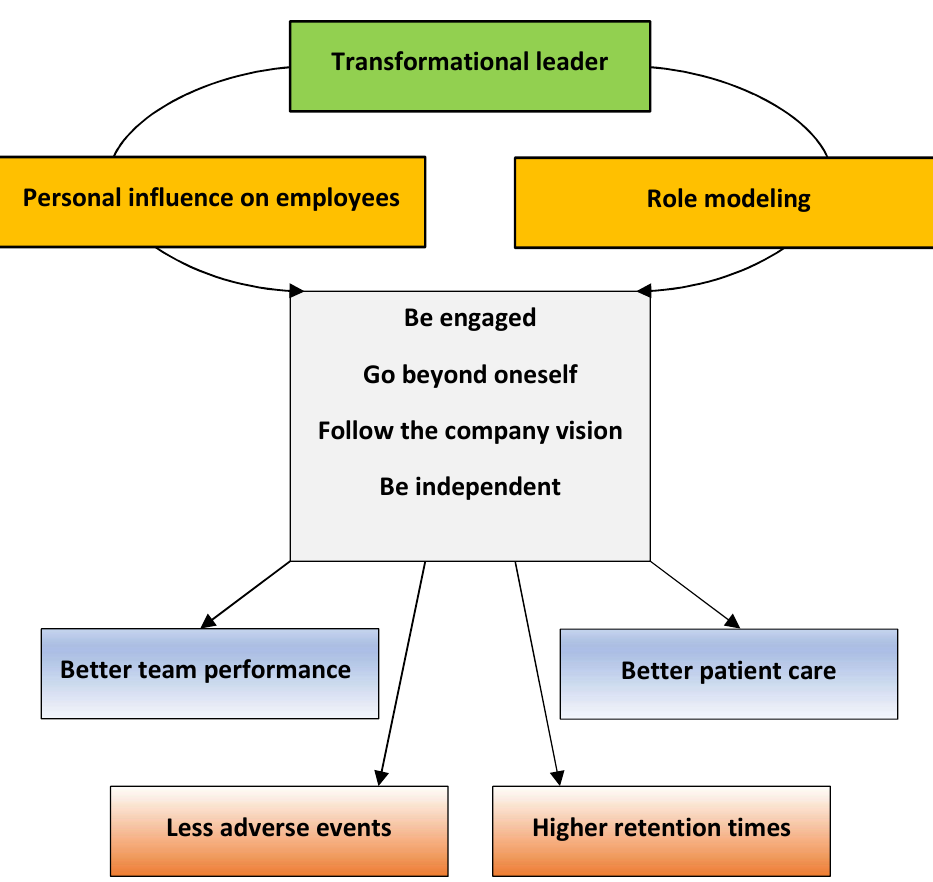
Figure 1. Potential effects of transformational leadership in health